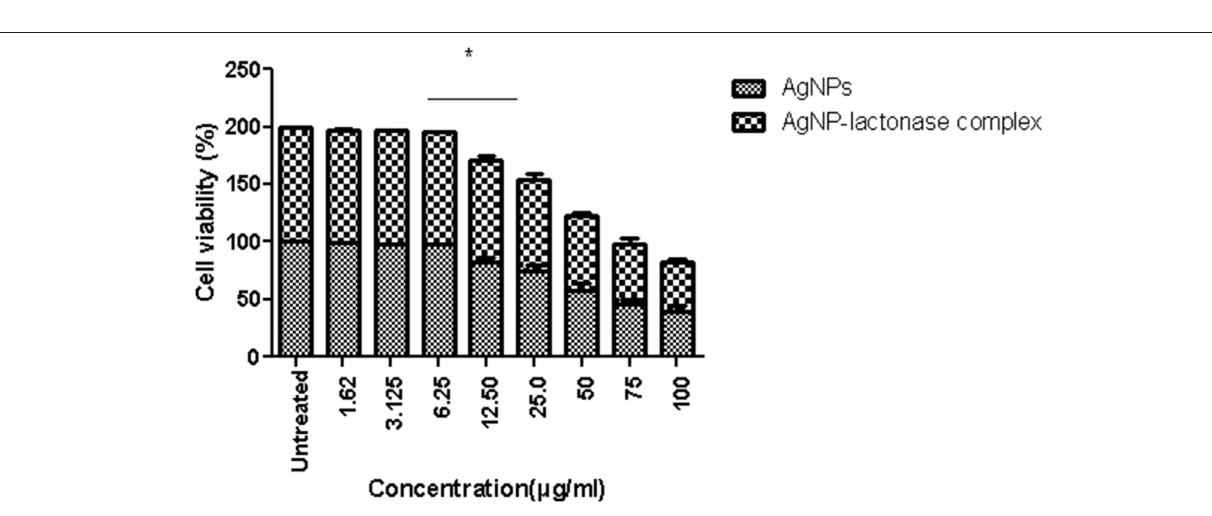
FIGURE 13 | Viability of macrophage cells in presence of varying concentrations (1.62–100 µ g/ml) of AgNPs and AgNP-AiiA complex as determined by MTT assay. Bars above the histogram represent standard deviation of mean value of three independent values. Results of the one way ANOVA shows that effect of concentration of AgNPs and AgNP-AiiA complex from 6.25 to 12.50 µ g/ml on macrophage cell line is significant ( p < 0.01,